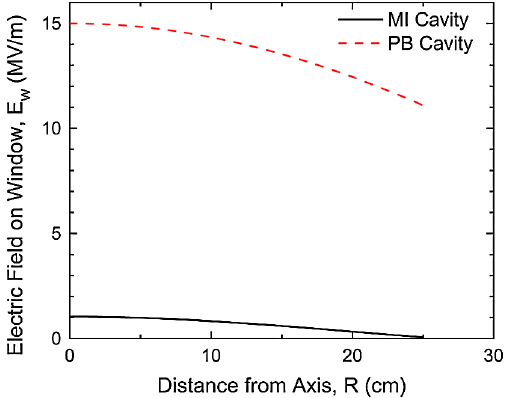
FIG. 6. The rf electric field distributions along the cooler Be window for a channel with magnetically insulated and pillbox cavities. The axis is at R ¼ 0 . Less window heating is antici- pated with our proposed magnetically insulated channel since the rf field drops by an order of